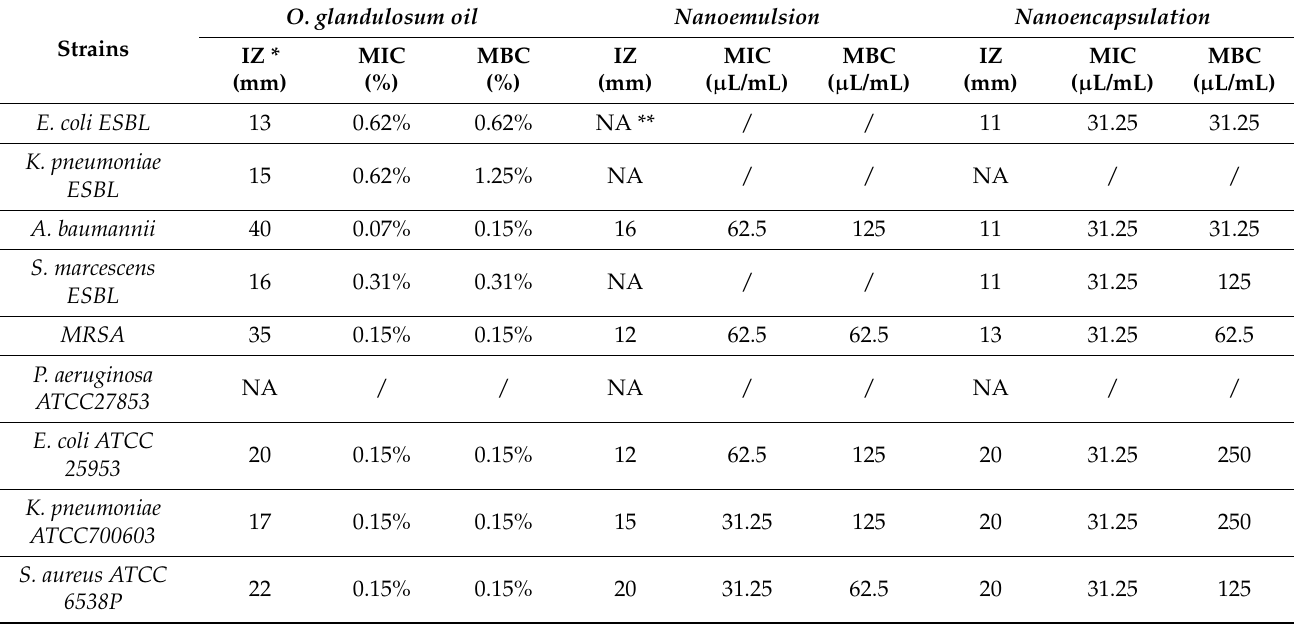
Table 5. Antibacterial activity of O. glandulosum HD oil and its nanoparticles against multidrug resistant isolates using three methods (Aromatogram, MIC, and